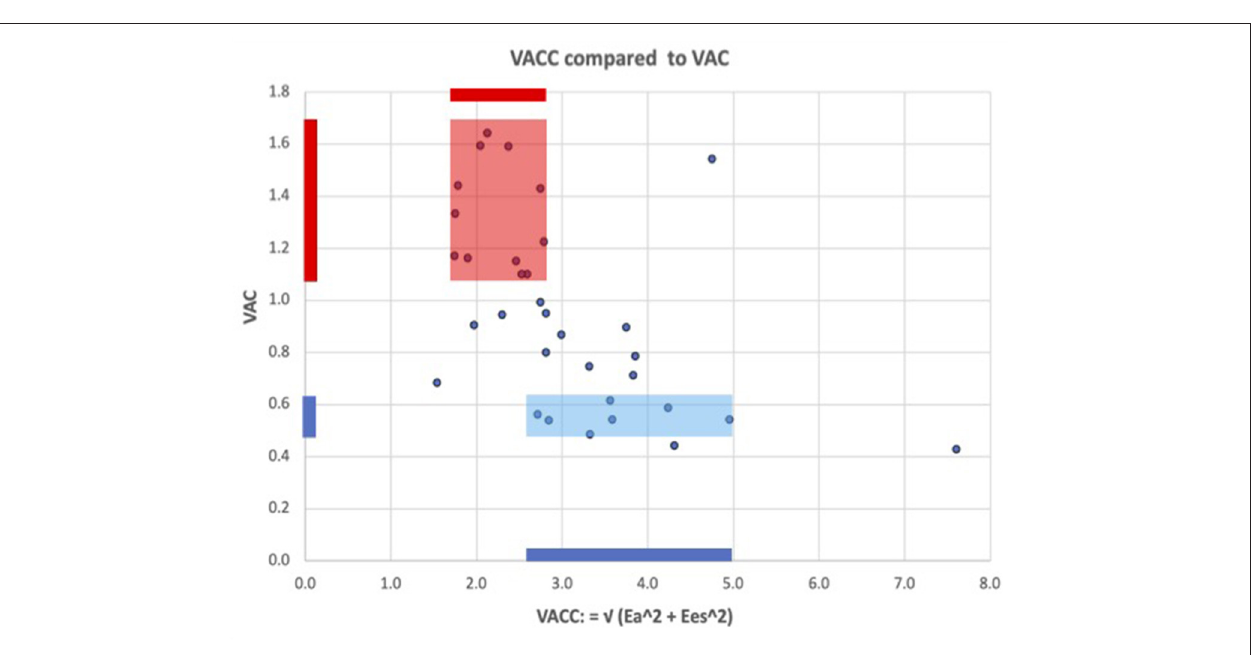
FIGURE 2 | ventricular arterial coupling and its companion: VACC information, i.e., VAC alone cannot adequately describe the arterio-ventricular coupling system. Blue color: for patients with a normal VAC, VACC has wide variations and greater values than in patients with abnormal elevated VAC (red color), where VACC has lesser values and more limited